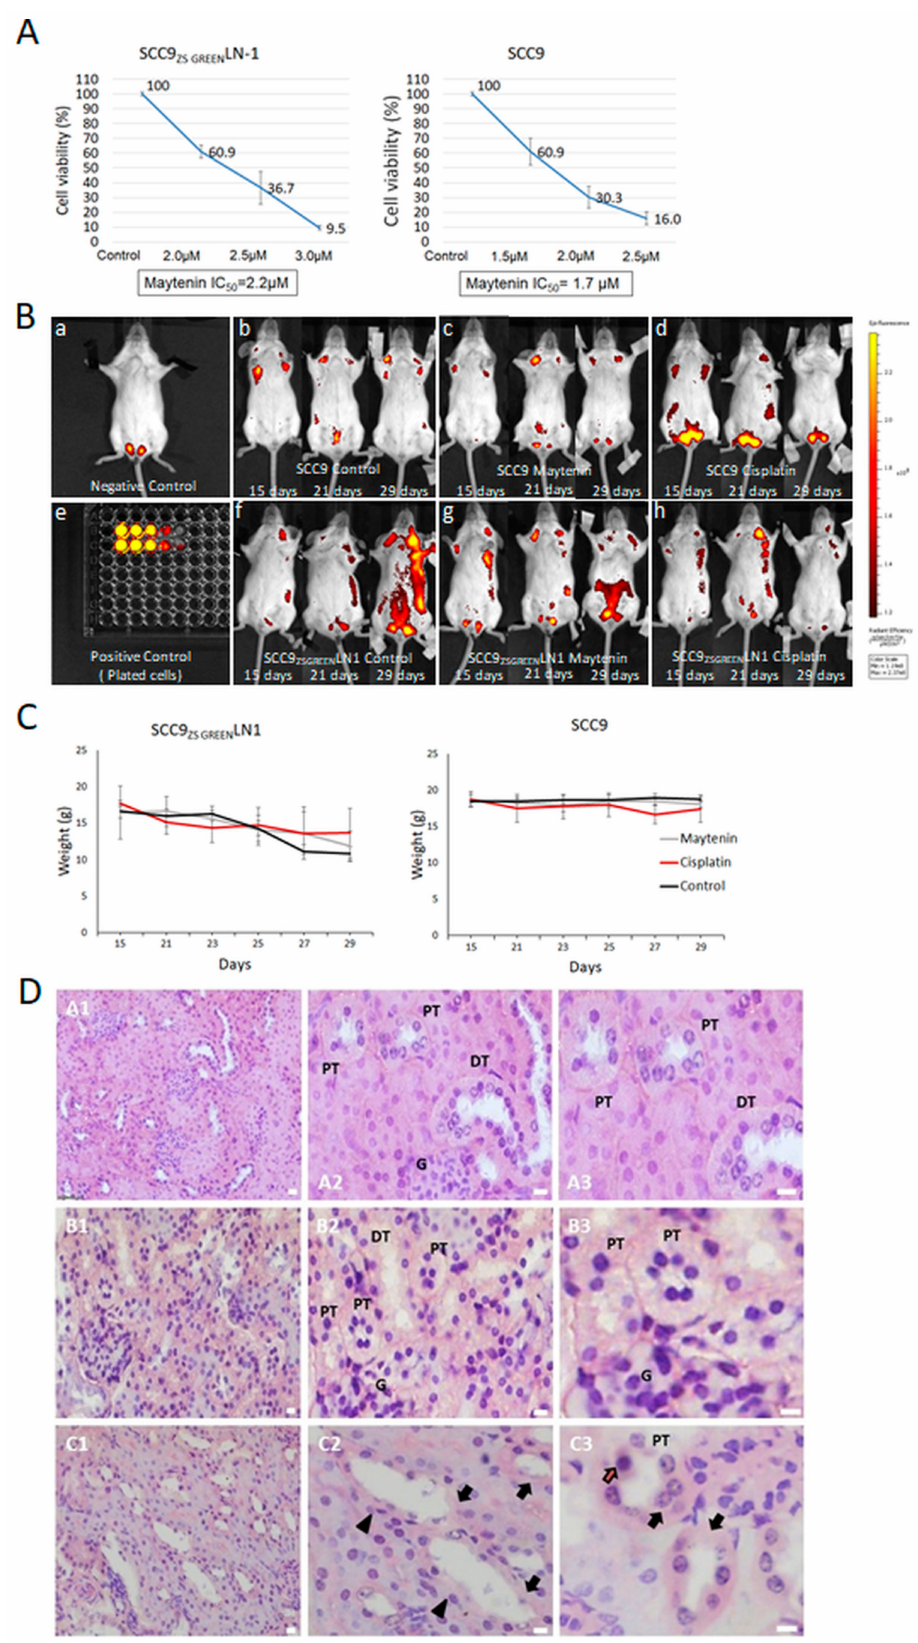
Figure 7. ( A ) Comparison of IC 50 of maytenin for SCC9 ZS GREEN and SCC9 ZS GREEN LN-1. Maytenin showed similar effect in cell viability for SCC9 ZS GREEN and SCC9 ZS GREEN LN-1 cell lines. ( B )